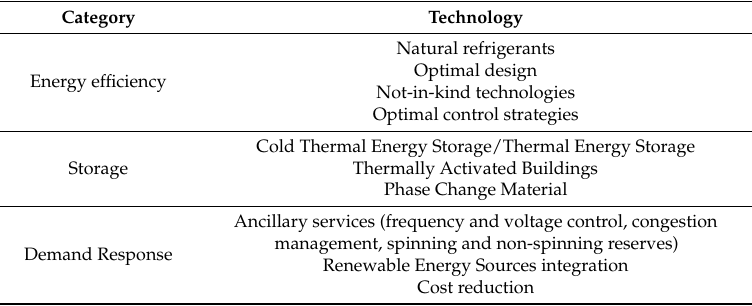
Table 1. Summary of the demand side management (DSM) technologies implemented in the heating ventilation and air conditioning (HVAC)